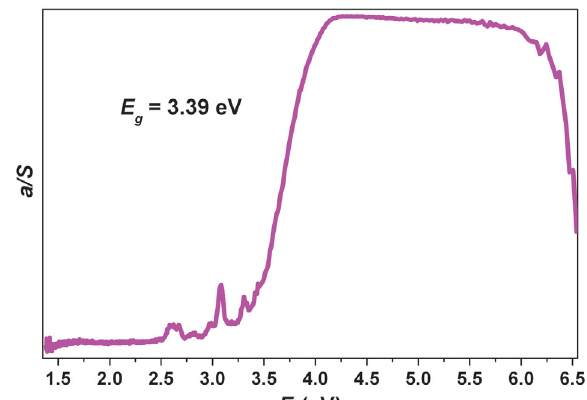
Figure 6. A solid-state diffuse reflectance spectrum of 1 .